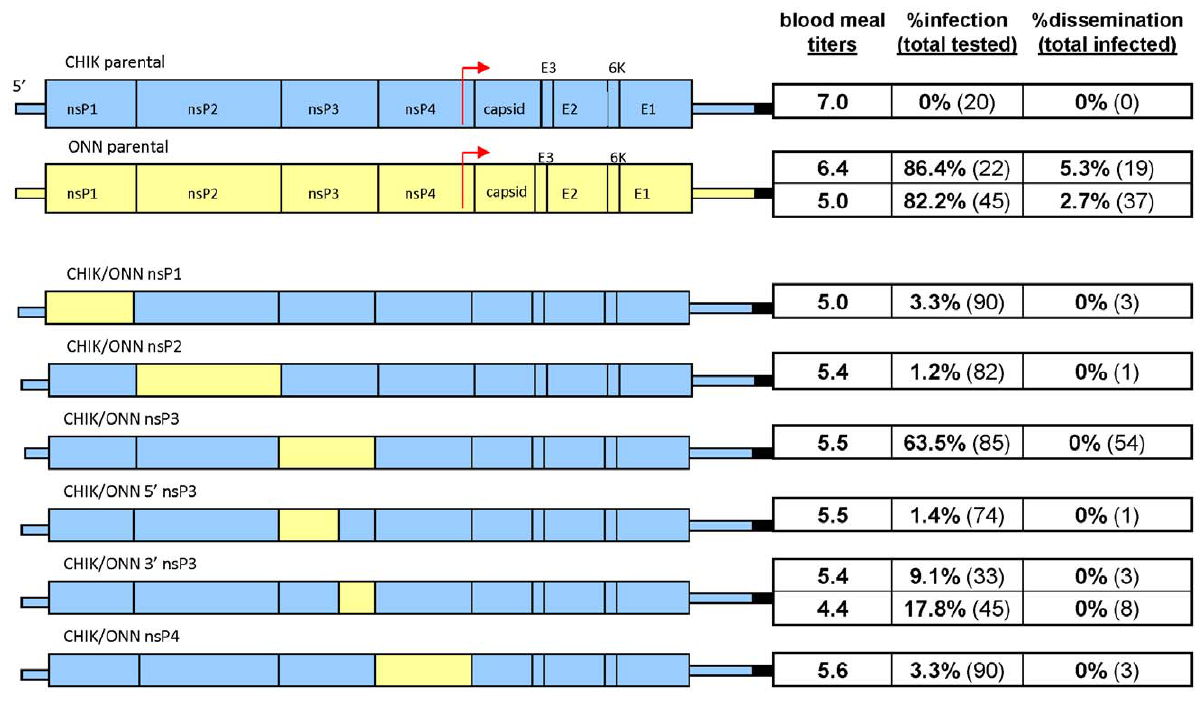
Figure 2. Infection rates with schematic diagrams. Infection rates at day 8 post-infection with parental and non-structural-region chimeric viruses in An. gambiae . Results are reported as in Figure 1. Infection rate is determined using mosquito bodies while dissemination rate is derived from heads.